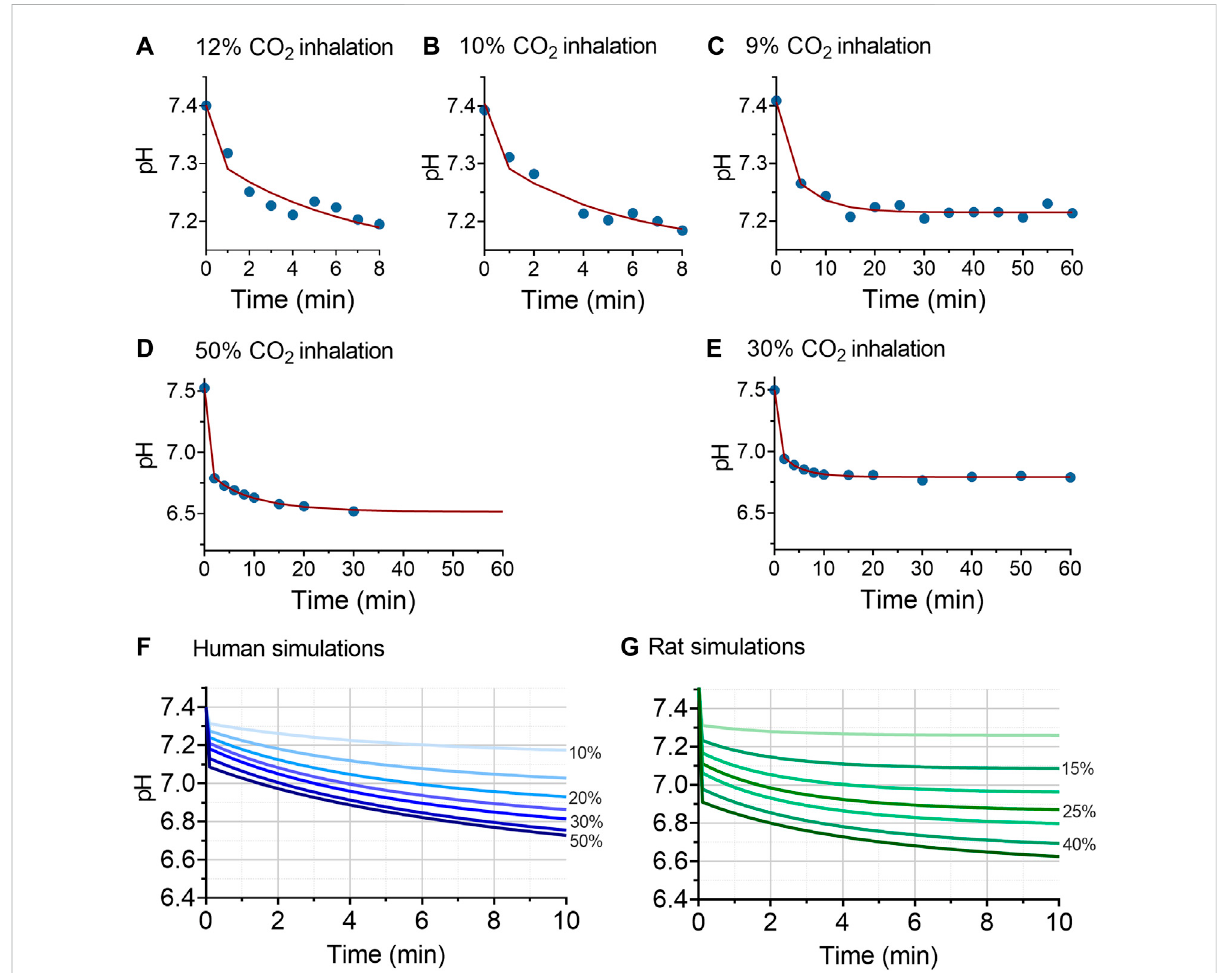
FIGURE 3 Results of the translational model analysis of acidosis (pH). Panels (A – E) given examples of the pH model fi ts in humans (A – C) and (D and E) in rats.Thebluecirclesarethemeasureddata,theredlinesthedata fi ts.Panels (FandG) givethesimulationsatinhalationvaluesof10%(toplinesinthe two panels), 15%, 20%, 25%, 30%, 40% and 50% (bottom lines in the two panels) CO 2 inhalation. The human simulations indicate that at inhalation levels of 15% CO 2 or higher, pH values < 7.2 are readily